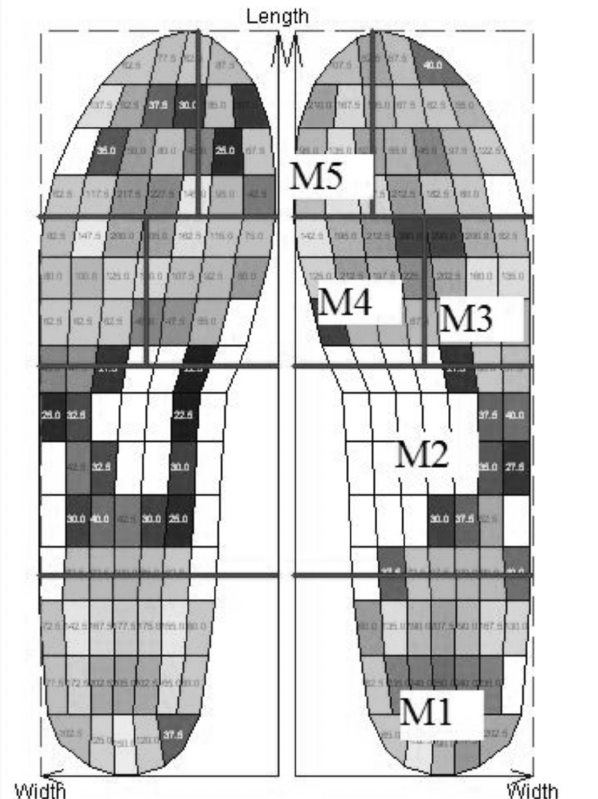
Figure 1 - Masks created in the Creation of Any Mask software (Novel) to analyze plantar pressure in five plantar areas: M1 – Rearfoot; M2 – Midfoot; M3 – Lateral Forefoot; M4 – Medial Forefoot; M5 –